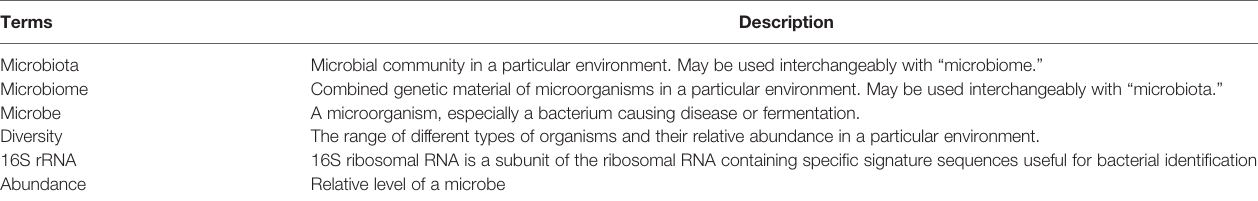
TABLE 1 | Glossary of